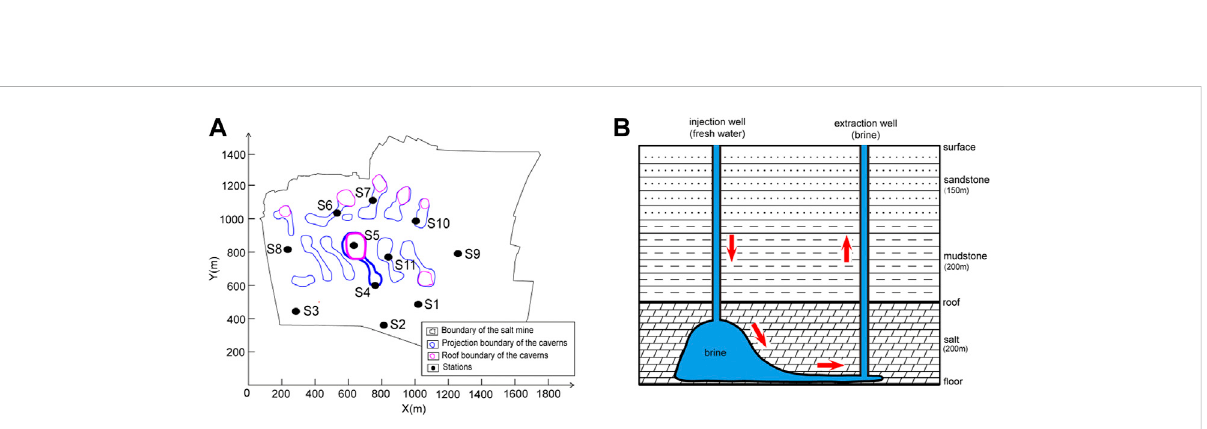
FIGURE 2 (A) Map showing the distribution of 11 seismic stations (black dots) and solution caverns (enclosed areas). The red and blue lines represent the roof and fl oor boundaries of the caverns, respectively, which are derived from the 3D active seismic imaging. The cavity with thickened lines is the cavern C1. (B) Layout diagram illustrating the dual-well solution mining. The cavern is full of the